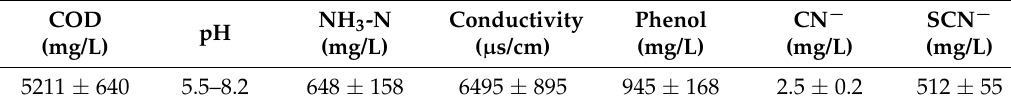
Table 2. Characteristics of coking wastewater.